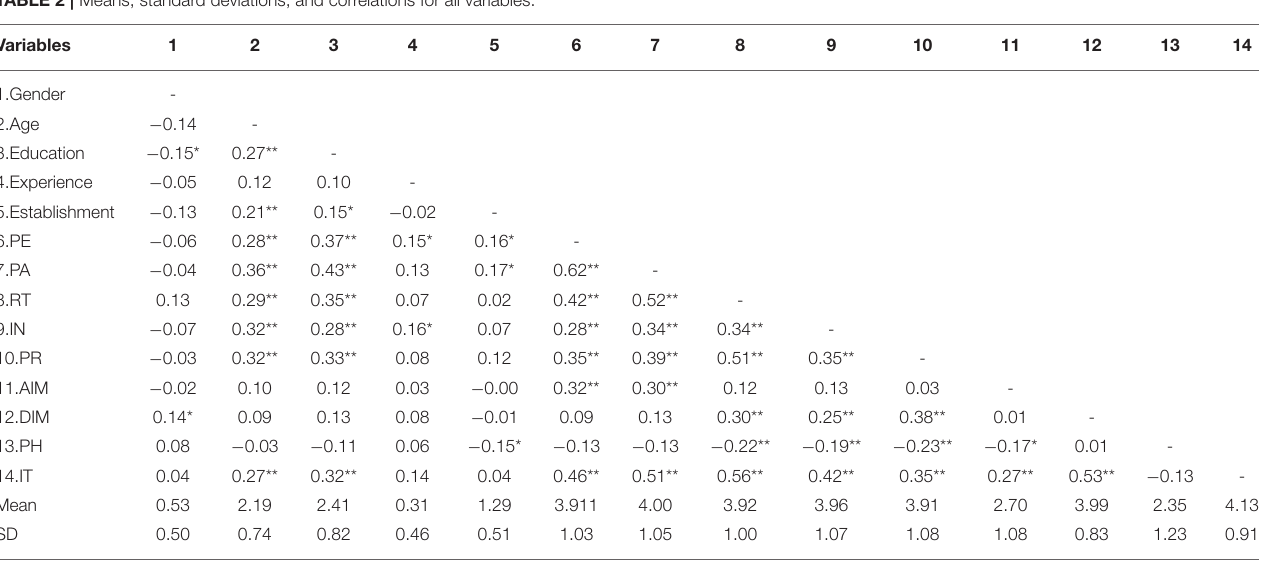
TABLE 2 | Means, standard deviations, and correlations for all